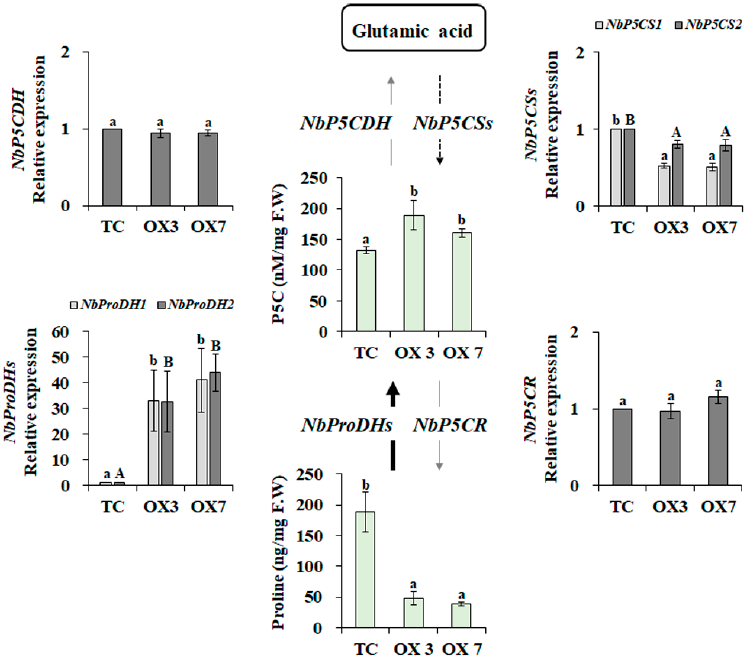
Figure 3. Proline metabolism in BrbZIP-S overexpressing N . benthamiana plants (OX3 and OX7 lines). Proline and pyrroline-5-carboxylate (P5C) contents were determined in BrbZIP-S -overexpressing (OX3 and OX7) and transgenic control (TC) plants. Expression levels of ProDHs (proline dehydrogenases), P5CDH (delta-1-pyrroline-5-carboxylate dehydrogenase), P5CR (pyrroline-5-carboxylate reductase), and P5CSs (pyrroline-5-carboxylate synthetases) were expressed as relative to TC plants. Means (±SE) with different letters are significantly different (Duncan’s multiple range test, p < 0.05).